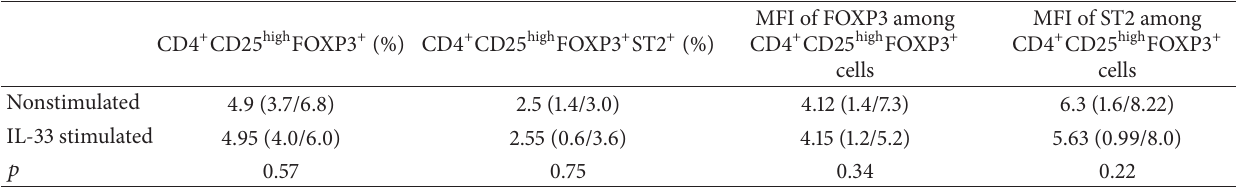
Table 3: The status of CD4 + CD 25 high FOXP3 + and CD4 + CD 25 high FOXP3 + ST2 + Treg cells after in vitro treatment with IL-33 in control